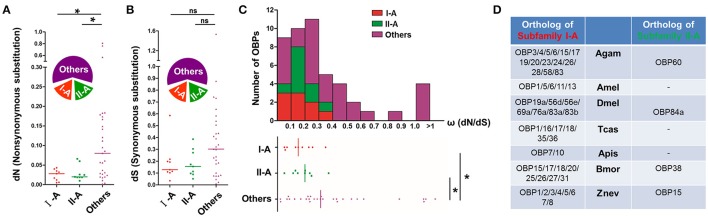
Selection constraints and orthology evolution of locust subfamily I-A and II-A. (A,B) Locust subfamily I-A and II-A OBPs exhibit a reduced dN rate, but a similar dS rate in comparison with the other locust OBPs. “Others” include those OBPs that do neither belong to subfamily I-A nor to subfamily II-A. The relative fraction included in each OBP group is illustrated by the wedges diagrams. Non-synonymous substitution rates (dN) and synonymous substitution rates (dS) were calculated across the locust OBP repertoire. The median level is indicated by lines. *p < 0.05; ns, p > 0.05; two-tailed Mann-Whitney U-test. Detailed data of this analysis are given in Figure S2. (C) Proportional distribution of ω rates for the locust OBP repertoire. The majority of OBPs (~90%) fall into a ω range of 0–0.7. Yielded ω ratios (dN and/or dS ≠ 0) and the median level are displayed at the bottom. *p < 0.05; two-tailed Mann-Whitney U-test. Nucleotide sequences utilized in this analysis are given in the supplementary material. (D) Orthologs of locust subfamily I-A and II-A OBPs in seven other insect species. It is noted that the complete genome has been sequenced for the seven inspected species, namely, Anopheles gambiae (Agam), Apis mellifera (Amel), Drosophila melanogaster (Dmel), Tribolium castaneum (Tcas), Acyrthosyphon pisum (Apis), Bombyx mori (Bmor), and Zootermopsis nevadensis (Znev). Orthology assignment was obtained by using EggNOG 4.5.1 which performed a hierarchical orthologous annotation (Huerta-Cepas et al., 2016). The criteria E-value for assessing orthologous relationship of locust subfamily I-A is set to e−20, while e−10 for subfamily II-A. Short bar denotes that there are no appropriate hints that could be assigned as orthologous OBPs. Nomenclature of OBPs for the seven inspected insect species conforms to Vieira and Rozas (2011) and Terrapon et al. (2014).